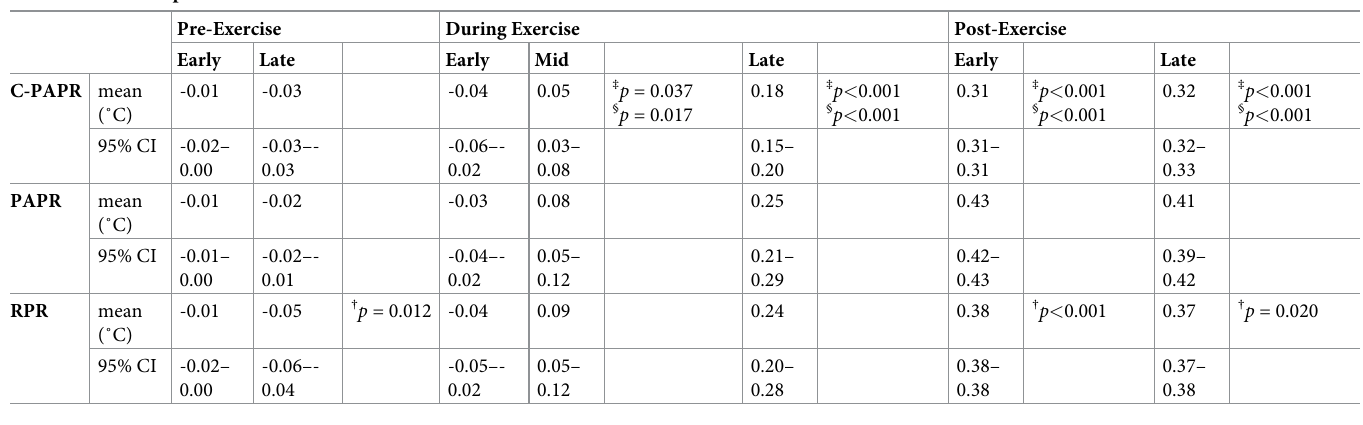
Table 2. Rectal temperature. Pre-Exercise During Exercise